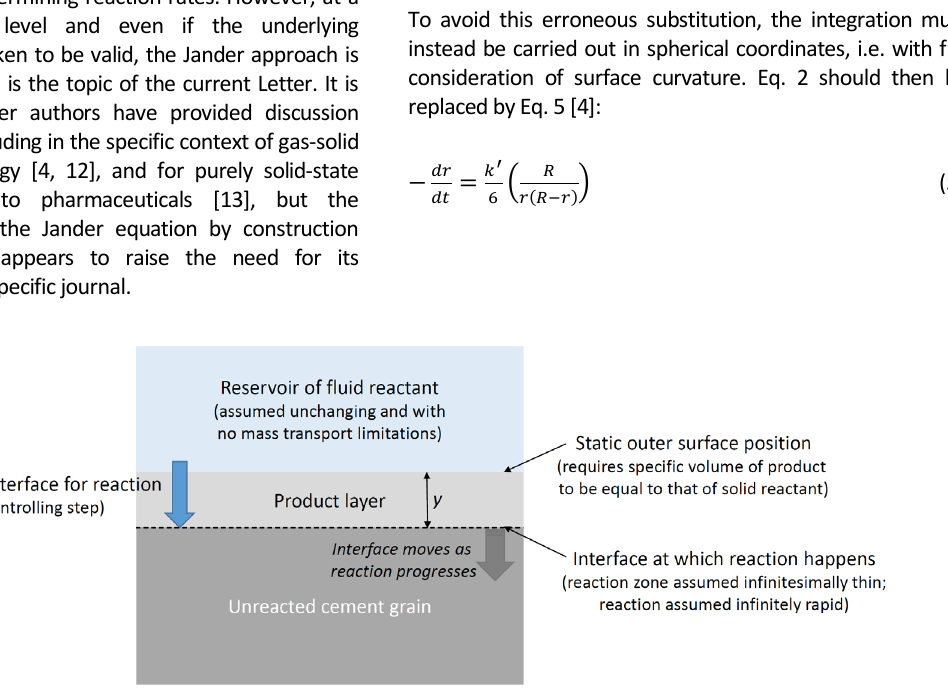
Figure 1. Depiction of the assumptions which are required for the derivation of the Jander equation, and the coordinate y (position of reaction interface) as used in the mathematical